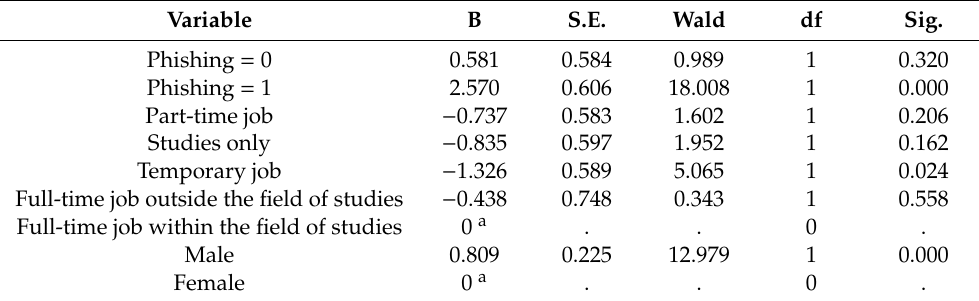
Table 6. Streamlined Model 3—Identity theft: ordinal logistic